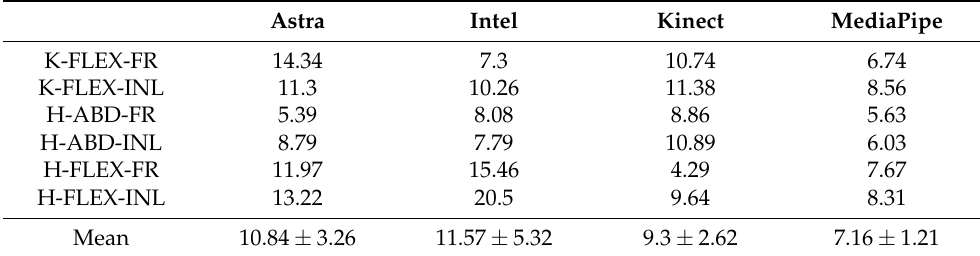
Table 7. Table of medians of absolute error for lower limbs in degrees ( ◦